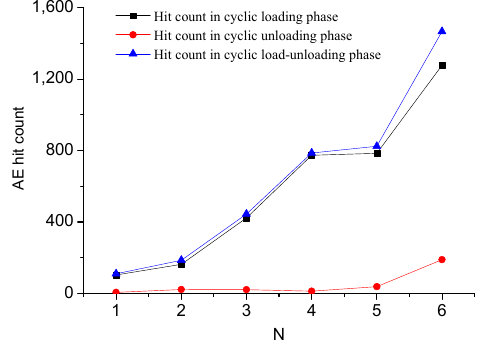
Figure 8. Cumulative AE hit count in different loading–unloading cycles.